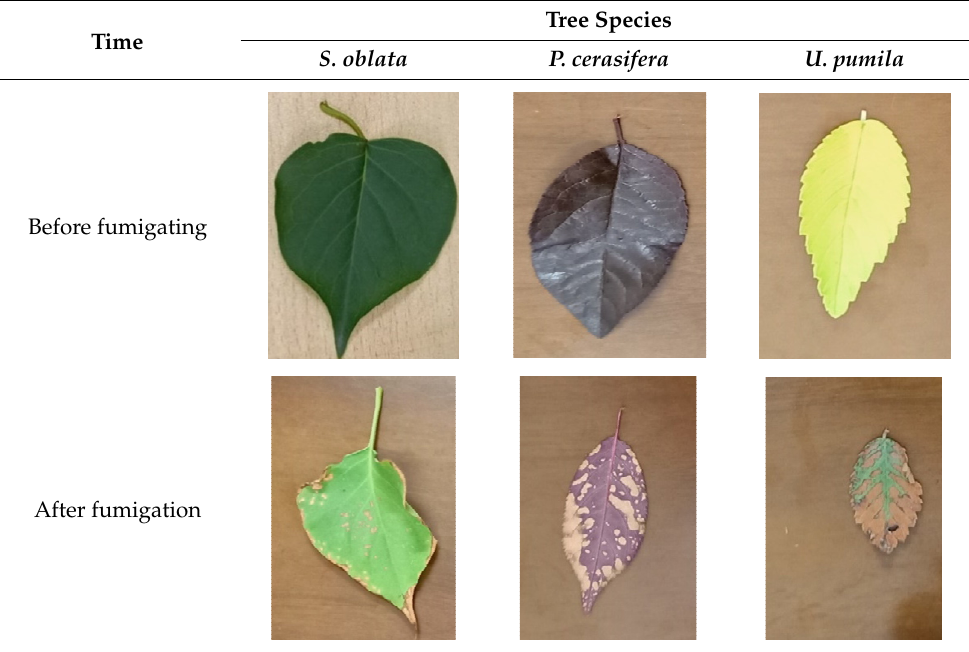
Table 1. Leaf morphology of the three tree species used in this study.